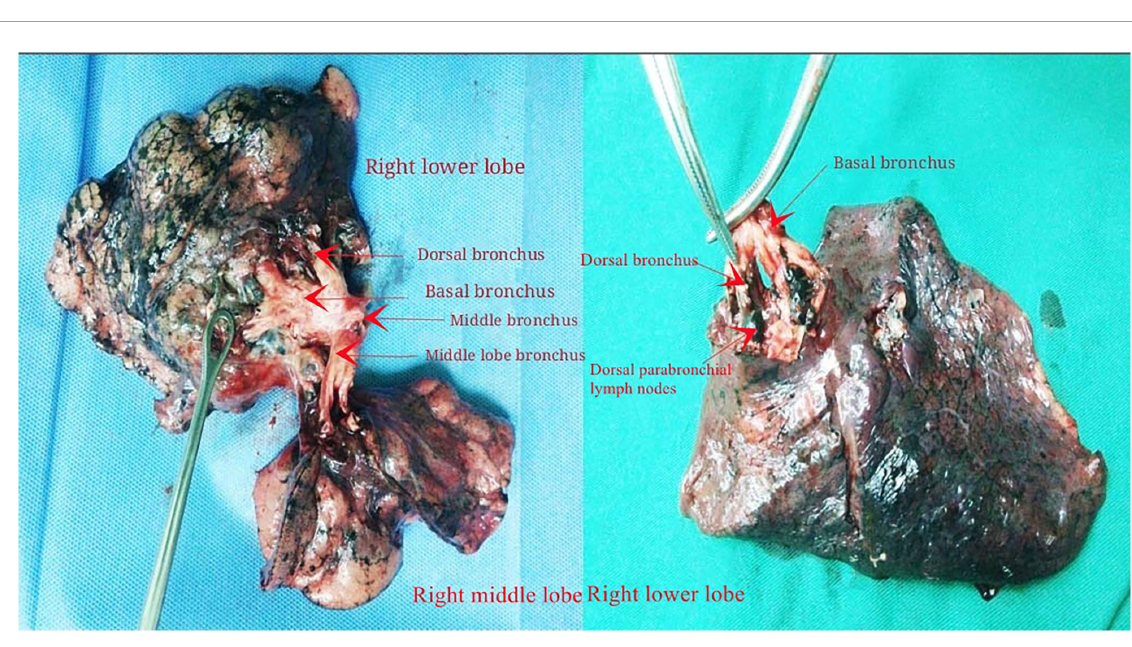
FIGURE2 Lung bronchial tree specimens after intrapulmonary lymph node dissection in the right middle/lower lobe and right lower